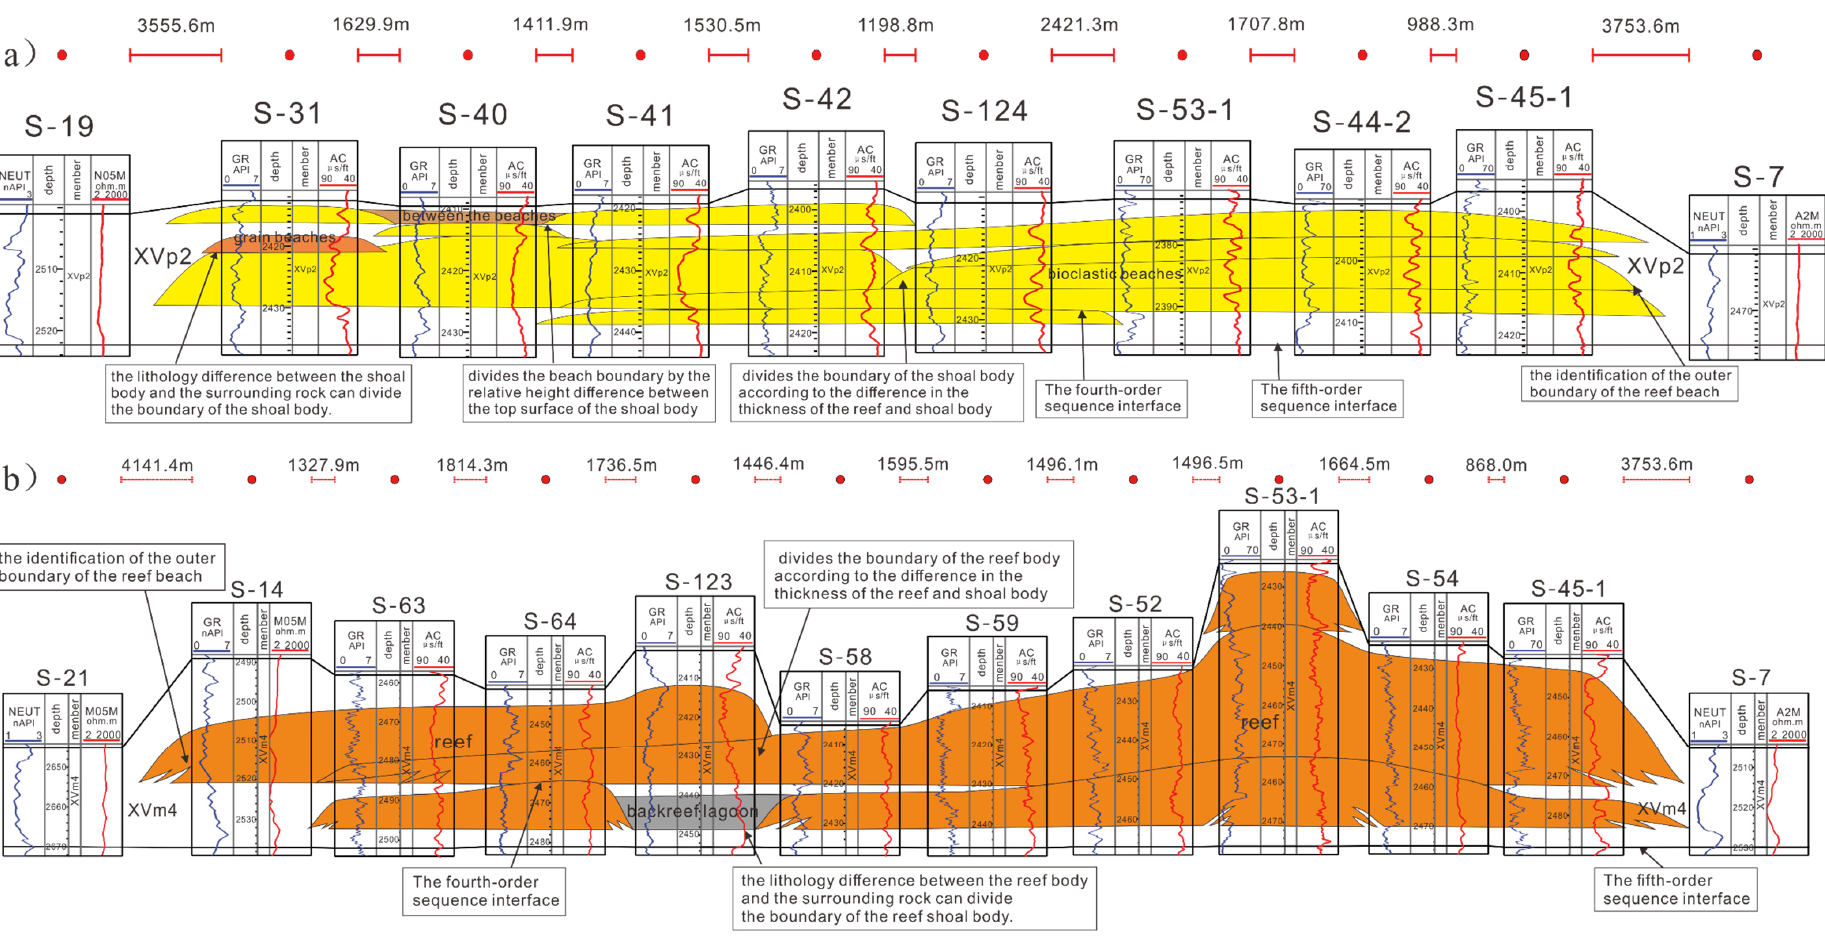
Figure 4. ( a ) Litho-correlation in the study area of shoal interpretation; ( b ) litho-correlation in the study area of reef interpretation.